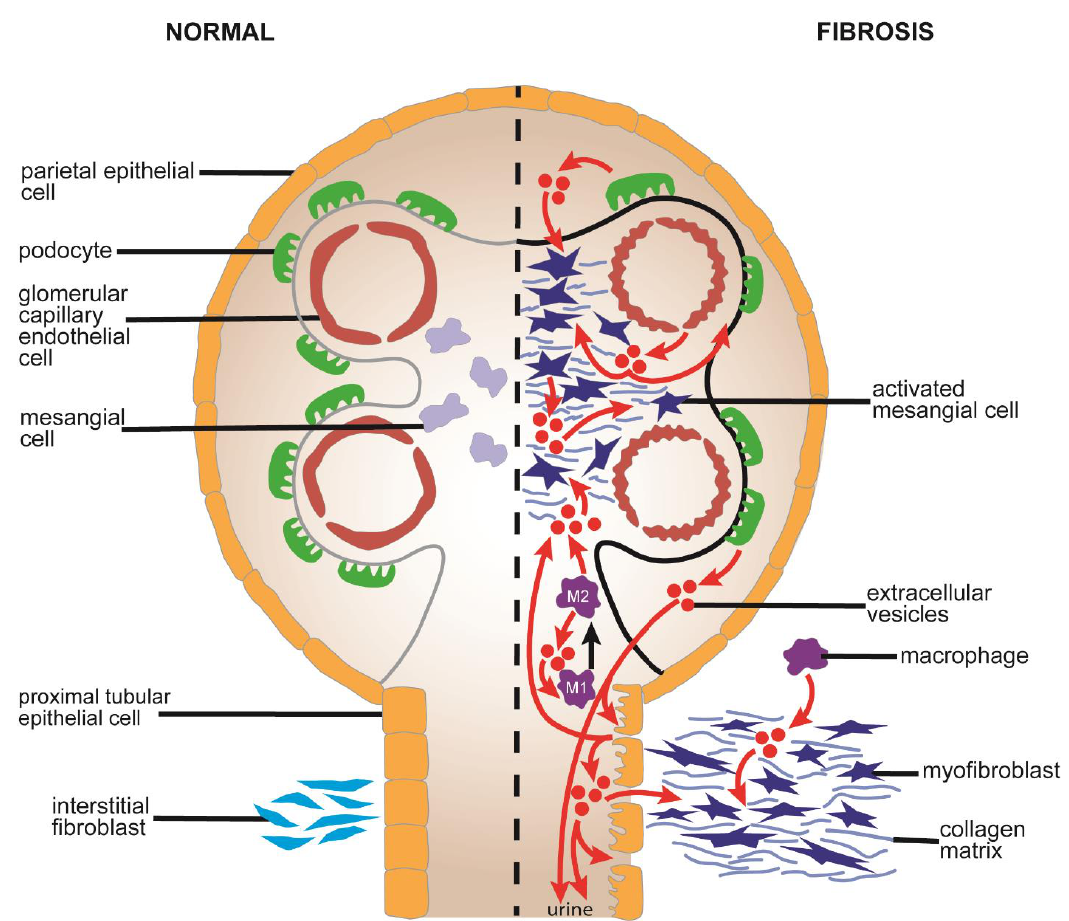
Figure 4. Proposed EV pathways in the pathogenesis of renal fibrosis . EVs are produced in enhanced numbers by stressed or injured TEC downstream of Shh and they cause proliferation and fibrogenesis in fibroblasts, in part by downregulation of SOCS2 by EV miR-196b-5p. TEC EVs also drive EMT and activation in TEC themselves via processes that are